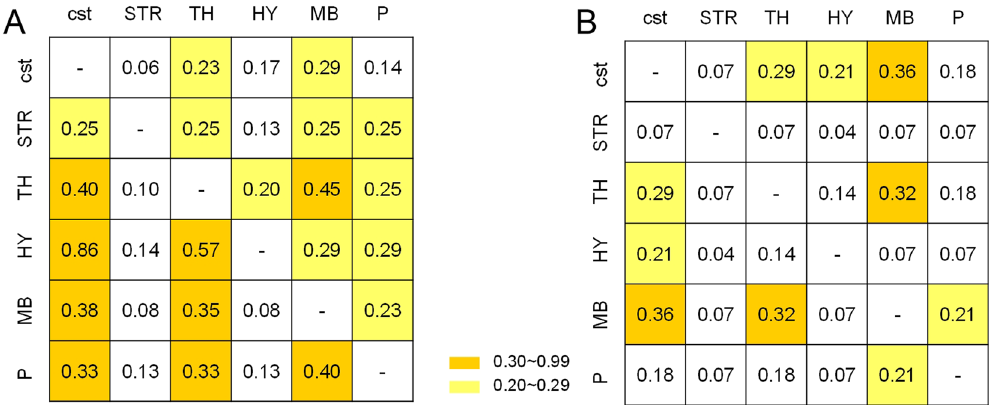
Figure 4. Quantification of the projection mode of L5 type I neurons. ( A ) The collaboration matrix quantifies the “posterior probability” of another projection region given the neuron projection to the current region. Taking the value in the second row and the third column as an example: 0.25 = Num ST / Num S , Num ST represents the number of multidirectional projection neurons to include the mode “ST”. Num S represents the number of neurons that project to the striatum. Similarly, the value in the third row and the second column can be calculated by: 0.10 = Num ST / Num T . ( B ) The coexistence matrix measures the occurrence frequency of two directional projection modes. Every element of the matrix represents the ratio of some neurons projecting to the two regions to all the neurons having at least two projection regions (n =